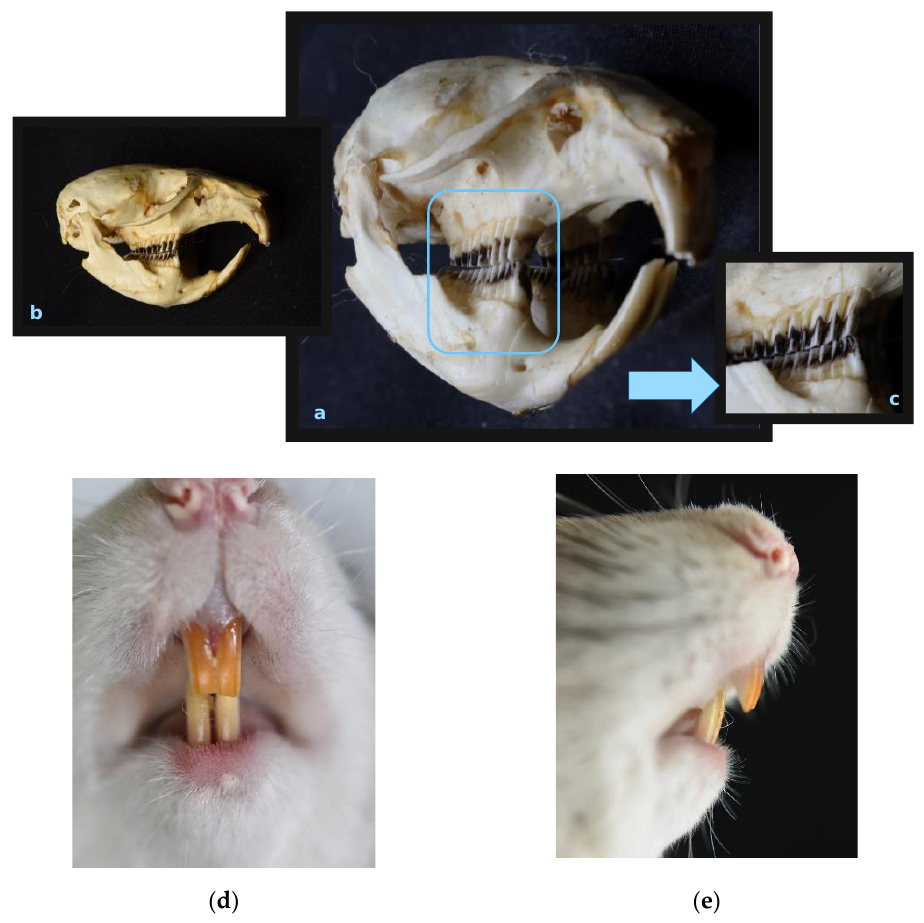
Figure 1. Rat teeth in a skull: semi profile view ( a ), lateral view ( b ), premolars and molars view ( c ). Rat teeth: incisors, frontal view — enlarged overbite ( d ) and incisors, lateral view — enlarged overjet ( e ) (by Małgorzata Peruga) .